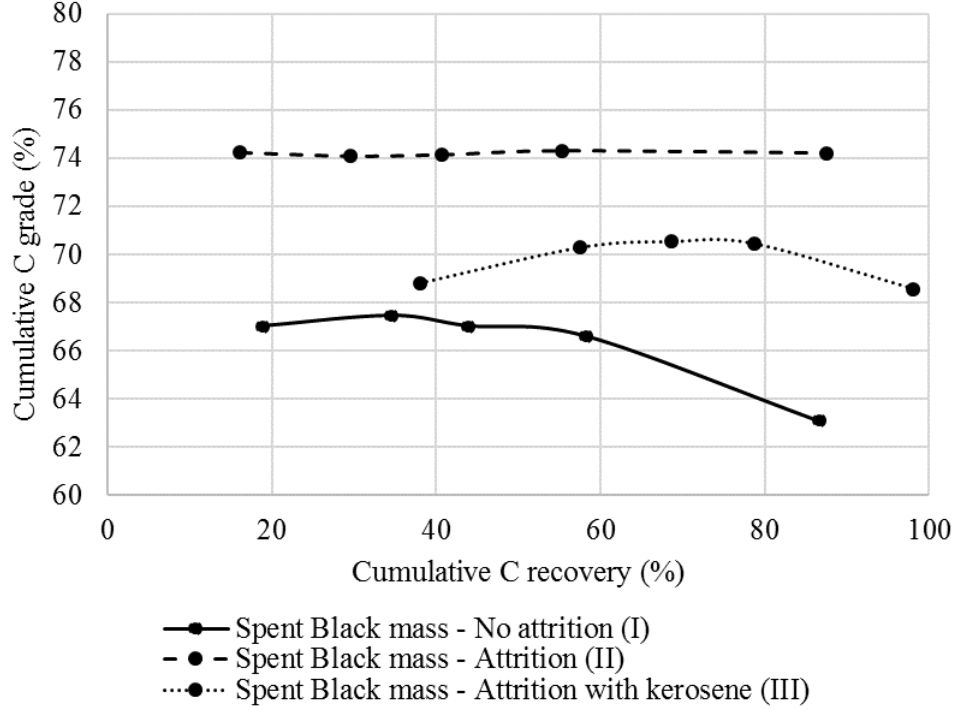
Figure 3. Grade and recovery of carbon in the overflow product according to the flotation flow: no attrition ( I ), with attrition ( II ), and attrition with kerosene ( III ).